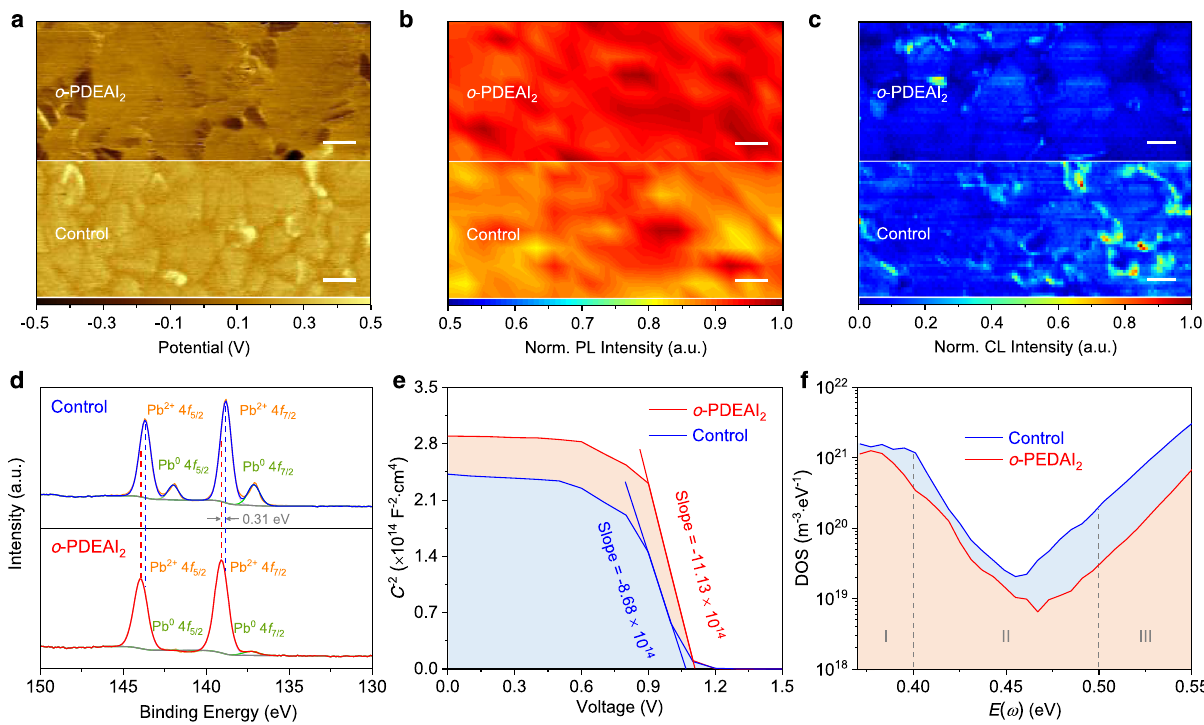
Fig. 4 Characterization of the perovskite fi lms and interface with o -PDEAI 2 . a KPFM images of perovskite fi lms showing the electronic chemical potential. b Normalized PL intensity maps of the perovskite fi lms illustrating the fi lm homogeneity. c Normalized CL mapping images of the perovskite fi lms. d High-resolution Pb 4 f core-level XPS spectra of perovskite fi lms. e Mott – Schottky plots of the devices revealing the interfacial charge density. f tDOS distribution in PSCs showing less trap densities after o -PDEAI 2